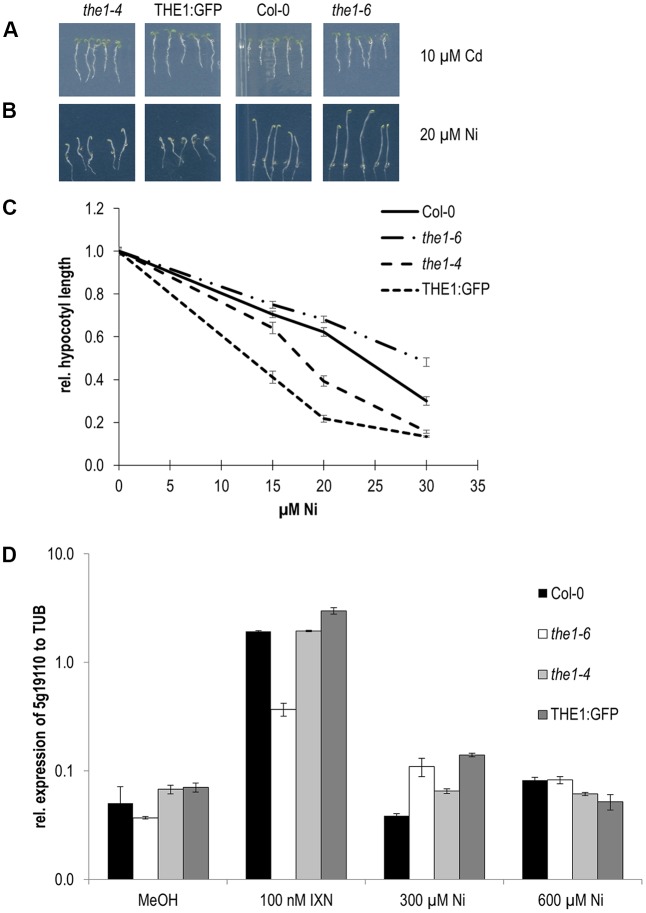
Responses of THE1 alleles to Cd and Ni. (A) Root growth on Cd, (B) etiolated hypocotyl elongation on Ni, (C) dose responses of Ni on etiolated hypocotyls, (D) expression of a downstream gene of the THE1 mediated cell wall damaging signaling pathway upon treatment with the cellulose biosynthesis inhibitor isoxaben (IXN), mock (MeOH) and different concentrations of Ni.